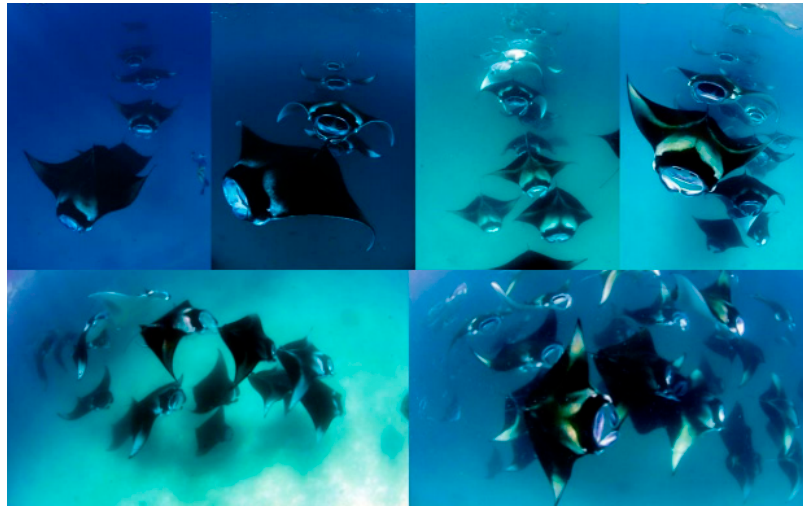
Figure 2. Manta ray chain foraging strategy.